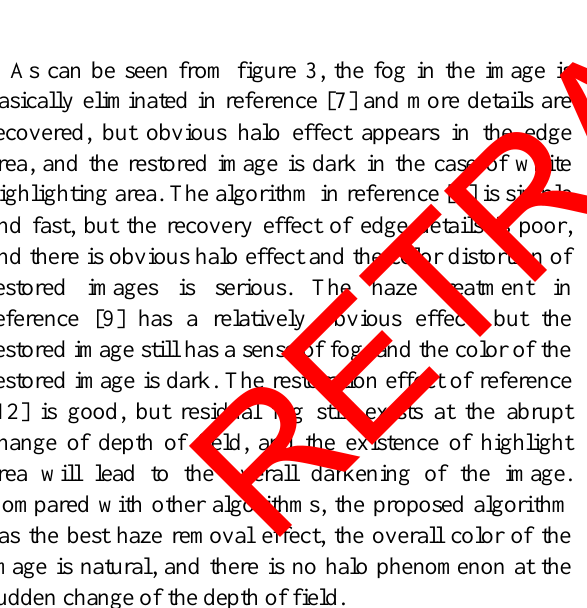
Figure 3. Effect of different algorithms for processing close-range images. (a) Original images; (b) Ref. [7]; (c) Ref. [8] ; (d) Ref. [9]; (e) Ref.